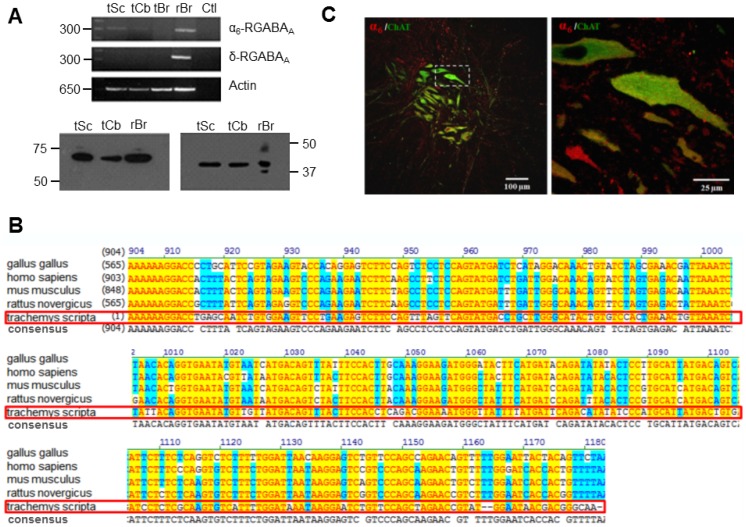
Expression of the α6 subunit of the GABAA receptor in the adult turtle spinal cord.A) RNA was extracted from the adult turtle spinal cord (tSc), cerebellum (tCb) and rat brain (rBr) used as a positive control, and subjected to RT-PCR with specific primers for the α6 and δ GABAA receptor subunits. Samples containing RNA which was not reverse transcribed were included as negative controls (Ctl). In the bottom panel actin amplification is shown as loading control. B) Proteins extracted from the turtle spinal cord (tSc) cerebellum (tCb) and rat brain (rBr; used as a positive control) were subjected to Western-blot using anti-α6 antibodies. A ∼57 KDa band corresponding to the molecular mass of the α6 subunit was present in the tSc and tCb lanes as well as in the rBr (left panel). In the right panel a membrane probed with anti-actin antibody is shown as loading control. C) The left panel shows a representative confocal micrograph from an adult turtle spinal cord slice immunostained with choline acetyltransferase (ChaT; a marker for motoneurons) shown in green and with anti-α6 antibodies shown in red, suggesting co-localization of both proteins (orange/yellow). Scale bar  = 100 µm. The right panel shows an enlargement of the boxed region in the left panel. Scale bar  = 25 µm.